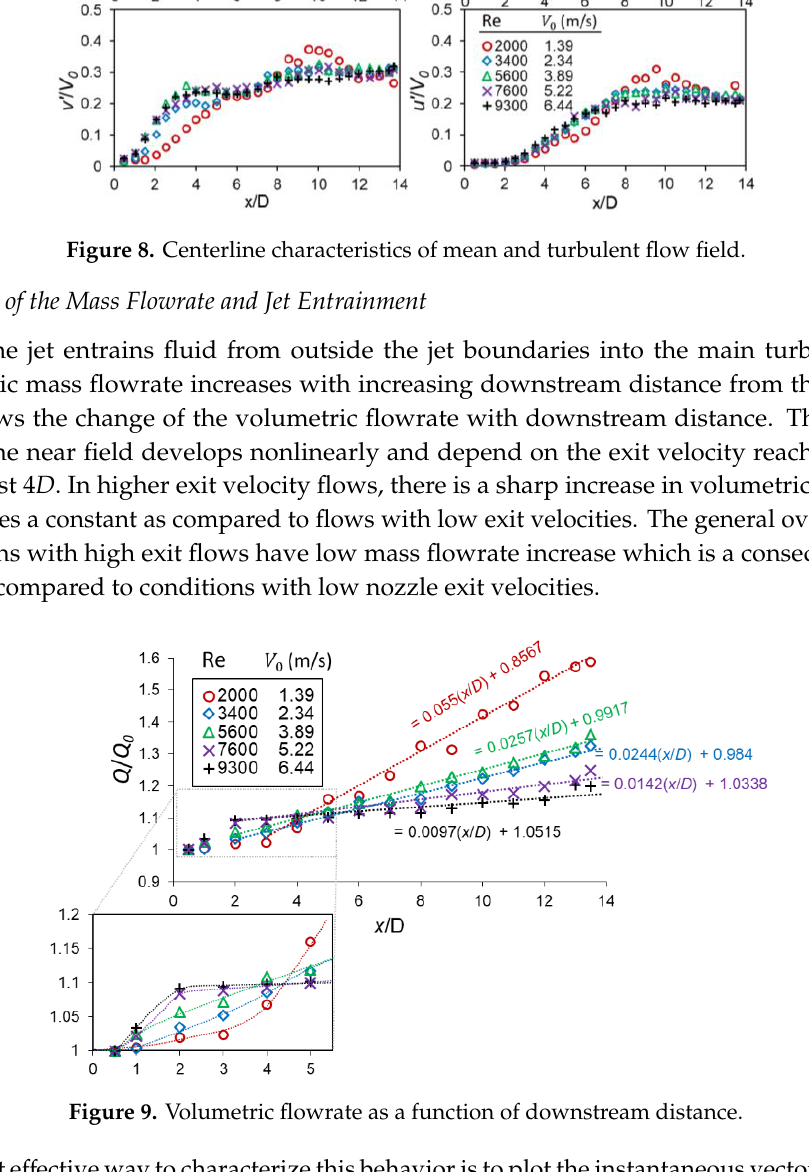
Figure 9. Volumetric flowrate as a function of downstream distance.